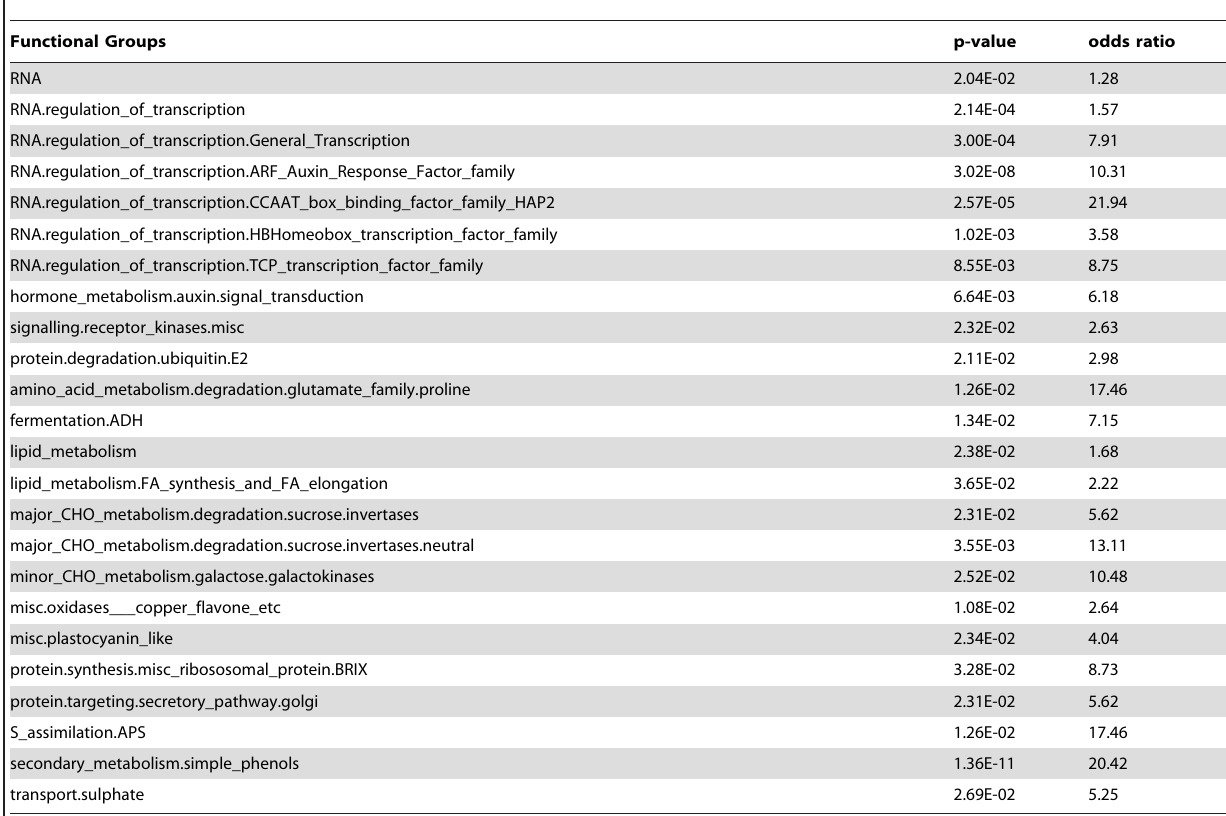
Table 3. Over-representation of Cotyledon miRNA Targeted Genes in Biological Pathways.